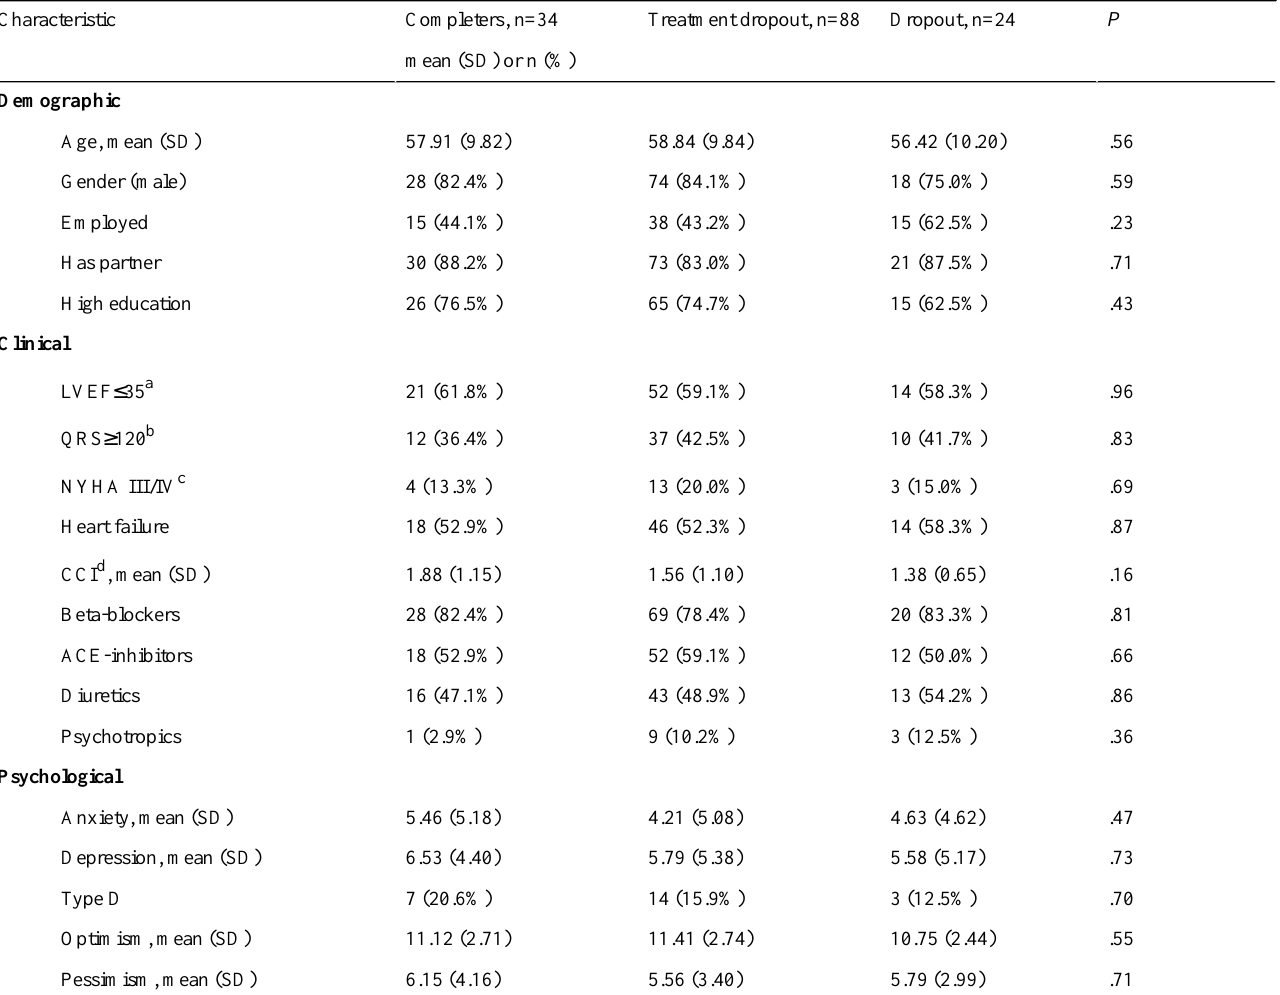
Table 2. Baseline demographic, clinical, and psychological characteristics stratified by